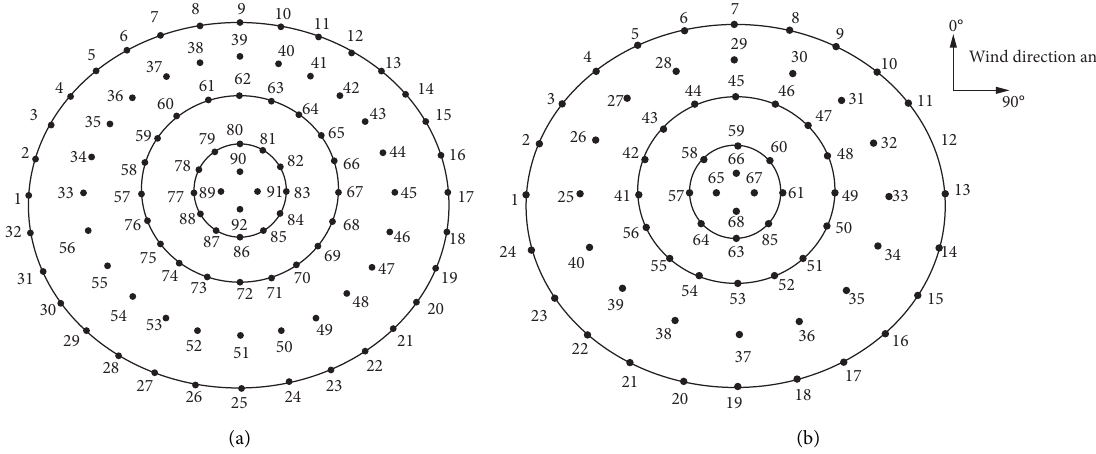
Figure 6: Layout of the gymnasium measuring points. (a) 92 measuring points. (b) 68 measuring